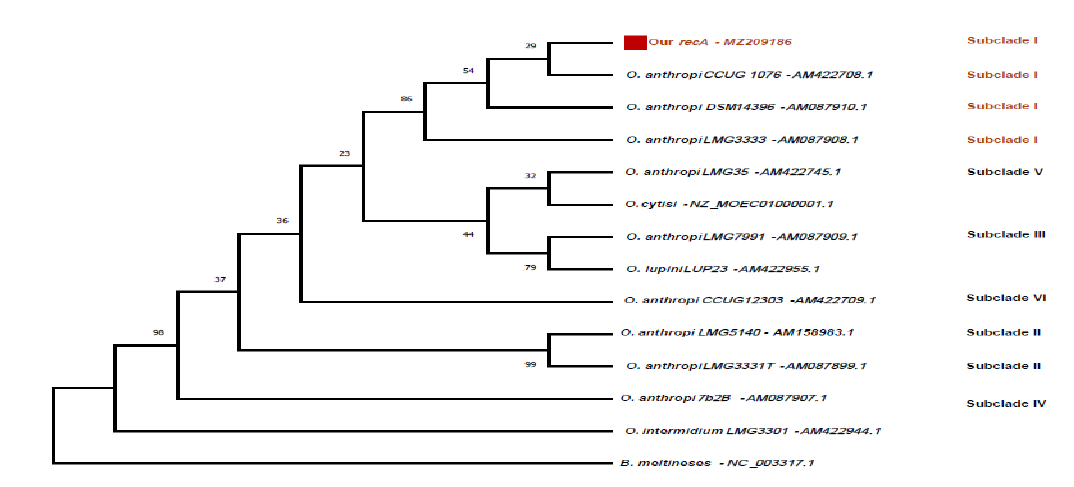
Figure 2. Phylogenetic tree for the different variants of